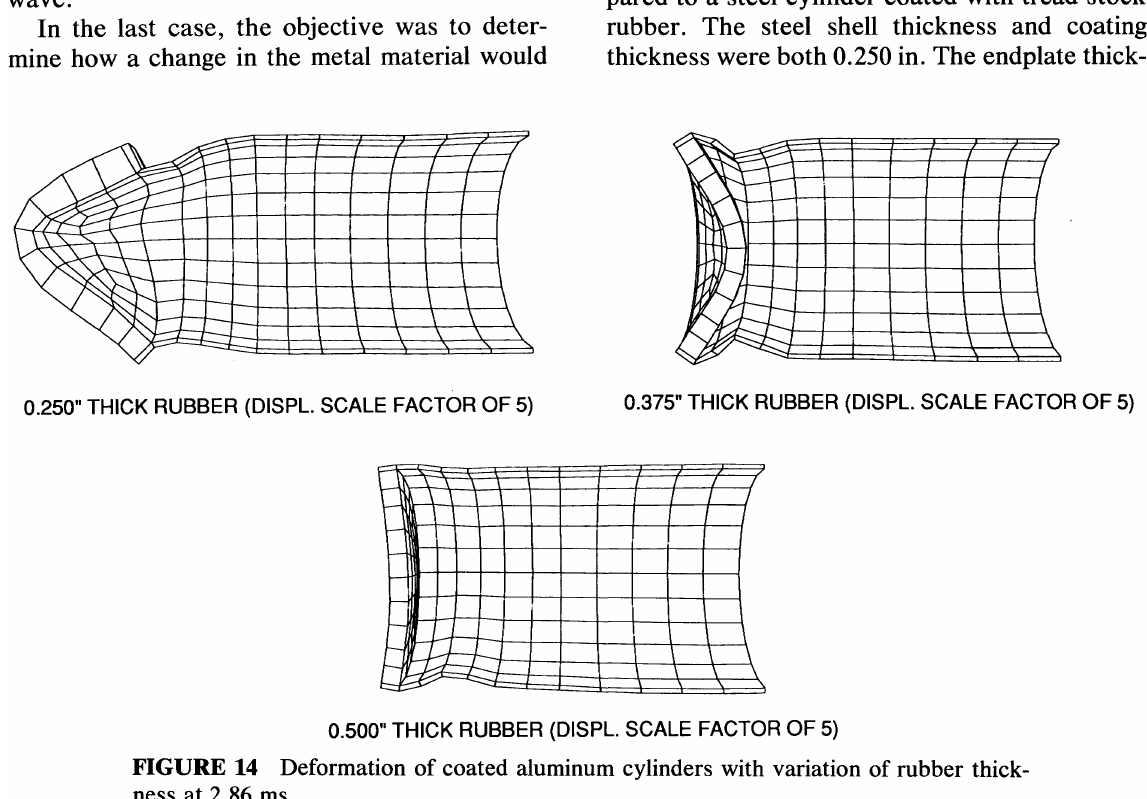
FIGURE 13 Internal energy of aluminum shell material of coated cylinders with variation of aluminum shell thickness.